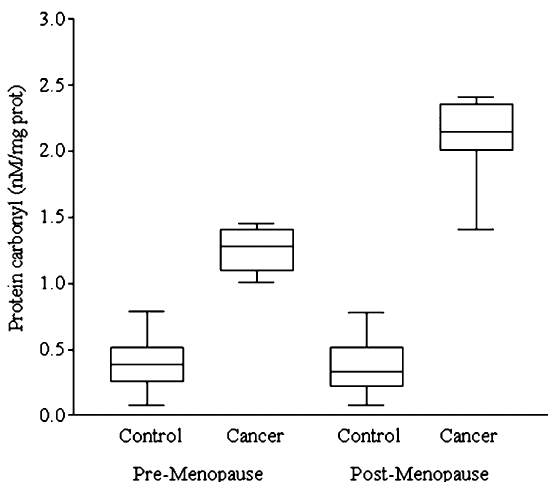
Fig. 2. Median levels of protein carbonyls in NAF collected from Control and Cancer women in pre-menopause ( n = 108 and n = 15, respectively) and in post-menopause ( n = 108 and n = 43, respectively). (Control pre-menopause vs. post-menopause, p = 0 . 115; Cancer pre-menopause vs. post-menopause, p < 0.0001; Control pre-menopause vs. Cancer pre-menopause, p < 0 . 0001; Control post-menopause vs. Cancer post-menopause, p < 0 .